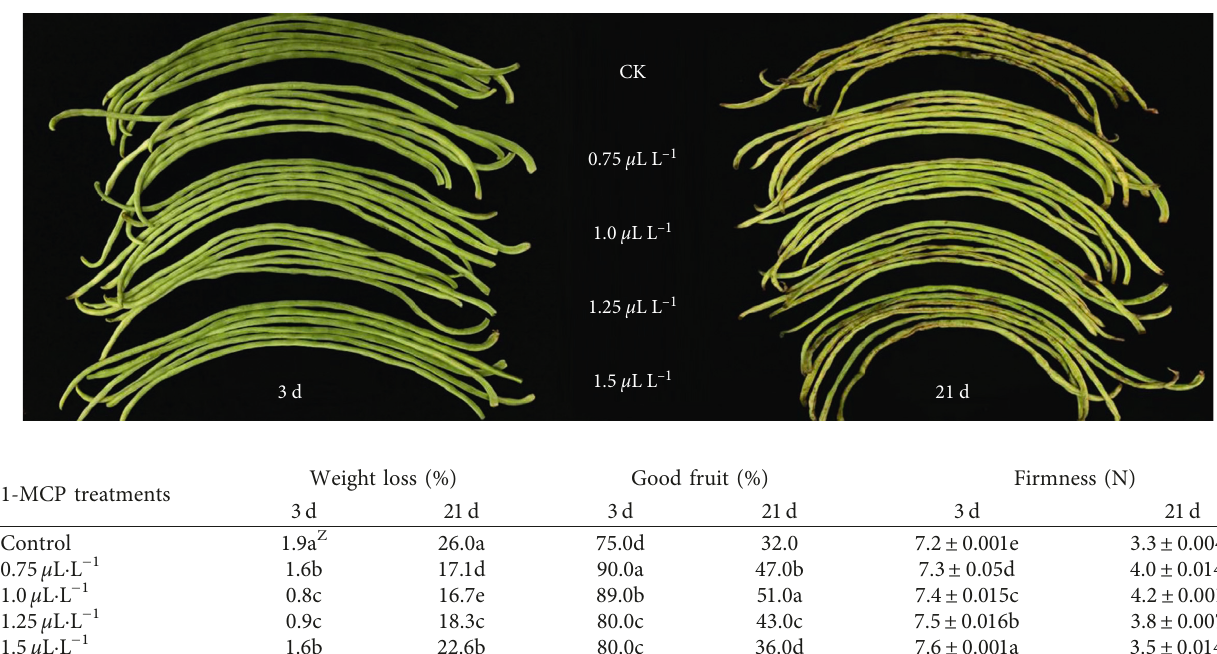
Table 1: Effects of 1-MCP treatment on weight loss, good fruit, and firmness of yardlong bean during storage at 8 ° C. Firmness values are mean ± standard error from three replicates. Photograph showing the effects of 1-MCP treatment on yardlong bean fruit after 21 days of storage at 8 °